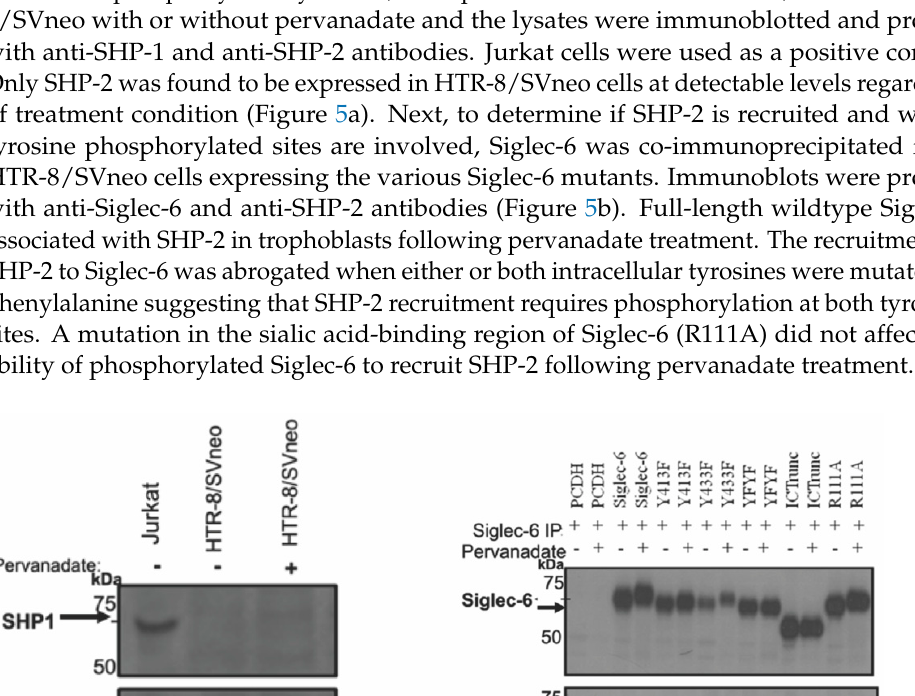
Figure 6. Inhibition of Src-kinases Prevents Siglec-6 Phosphorylation and SHP-2 Recruitment. HTR- 8/SVneo cells stably transfected with Siglec-6 or pCDH control were treated with PBS (control) or